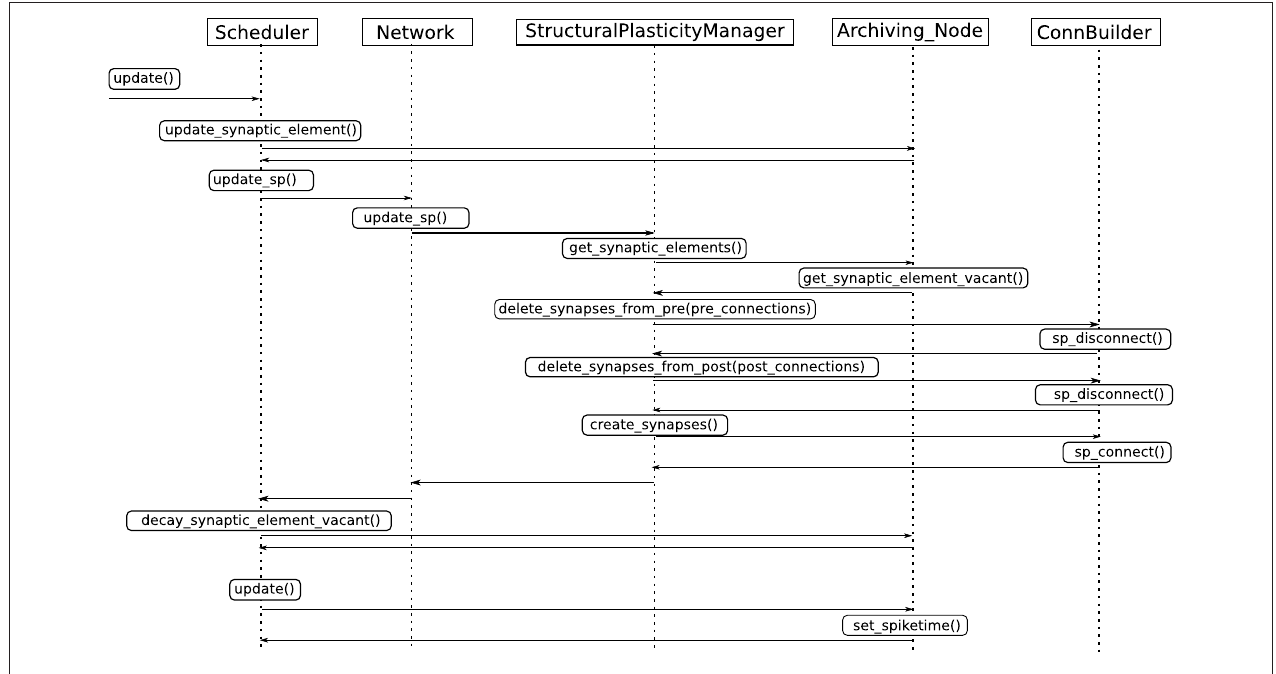
FIGURE 3 | Integration of the new structural plasticity calls into the normal simulation flow of NEST.